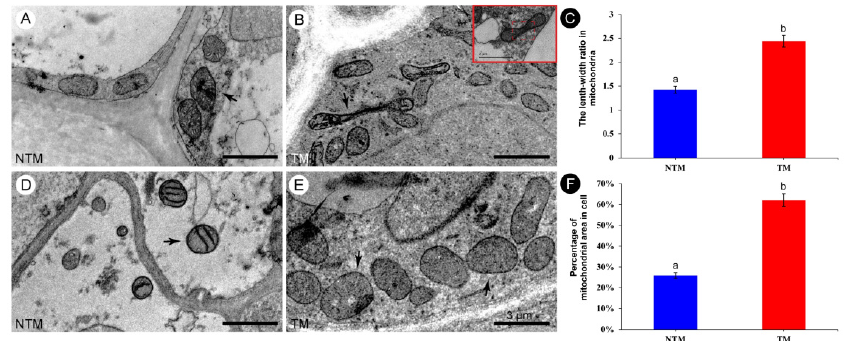
Figure 4. Morphology of mitochondria in the receptacle during the NTM and TM stages. ( A , D ) Morphology of mitochondria in the receptacle during the NTM (bud) stage. Most of the mitochon ‐ dria are round or elliptical. ( B , E ) Morphology of mitochondria in the receptacle during the TM (fe ‐ male) stage. Most of the mitochondria are rod ‐ shaped, long, elliptical, or dumbbell ‐ shaped, and some are obviously elongated. ( C ) Comparison of the mean length–width ratios of receptacle mito ‐ chondria during the NTM and TM stages. ( F ) Percentage of mitochondria to cell area in receptacle during NTM stage and TM stage. The different lowercase letters indicate a significant difference in the length–width ratio of mitochondria ( C ) and the mitochondrial coverage of cell ( F ) between the floral stages according to the t ‐ test. Data in the bars are the mean ± standard error, 74–91 mitochon ‐ dria per tissue section in ( C ) and 13–20 cells per tissue section of NTM and TM stage in ( F ). p < 0.001. Scale bars, 3 μ m. Figure 5. Reactive oxygen species (ROS) production and subcellular colocalization of ROS and mi ‐ tochondria in the receptacle during the NTM and TM stages. ( A ) Mitochondrial ROS production in receptacle cells during the NTM (bud) stage. ( B ) Mitochondrial ROS production in receptacle cells during the TM (female) stage. ( C ) Comparison of the mean fluorescence intensity of mitochondrial ROS in receptacle cells during the NTM and TM stages. In ( C ), the different lowercase letters indi ‐ cate a significant difference in fluorescence intensity of ROS between the floral stages according to the t ‐ test. Data in the bars are the mean ± standard error, n = 10 flowers, 3 sections per sample, 6 view fields for observation in ( C ). p < 0.001. ( D ) Mitochondrial fluorescence intensity in the recepta ‐